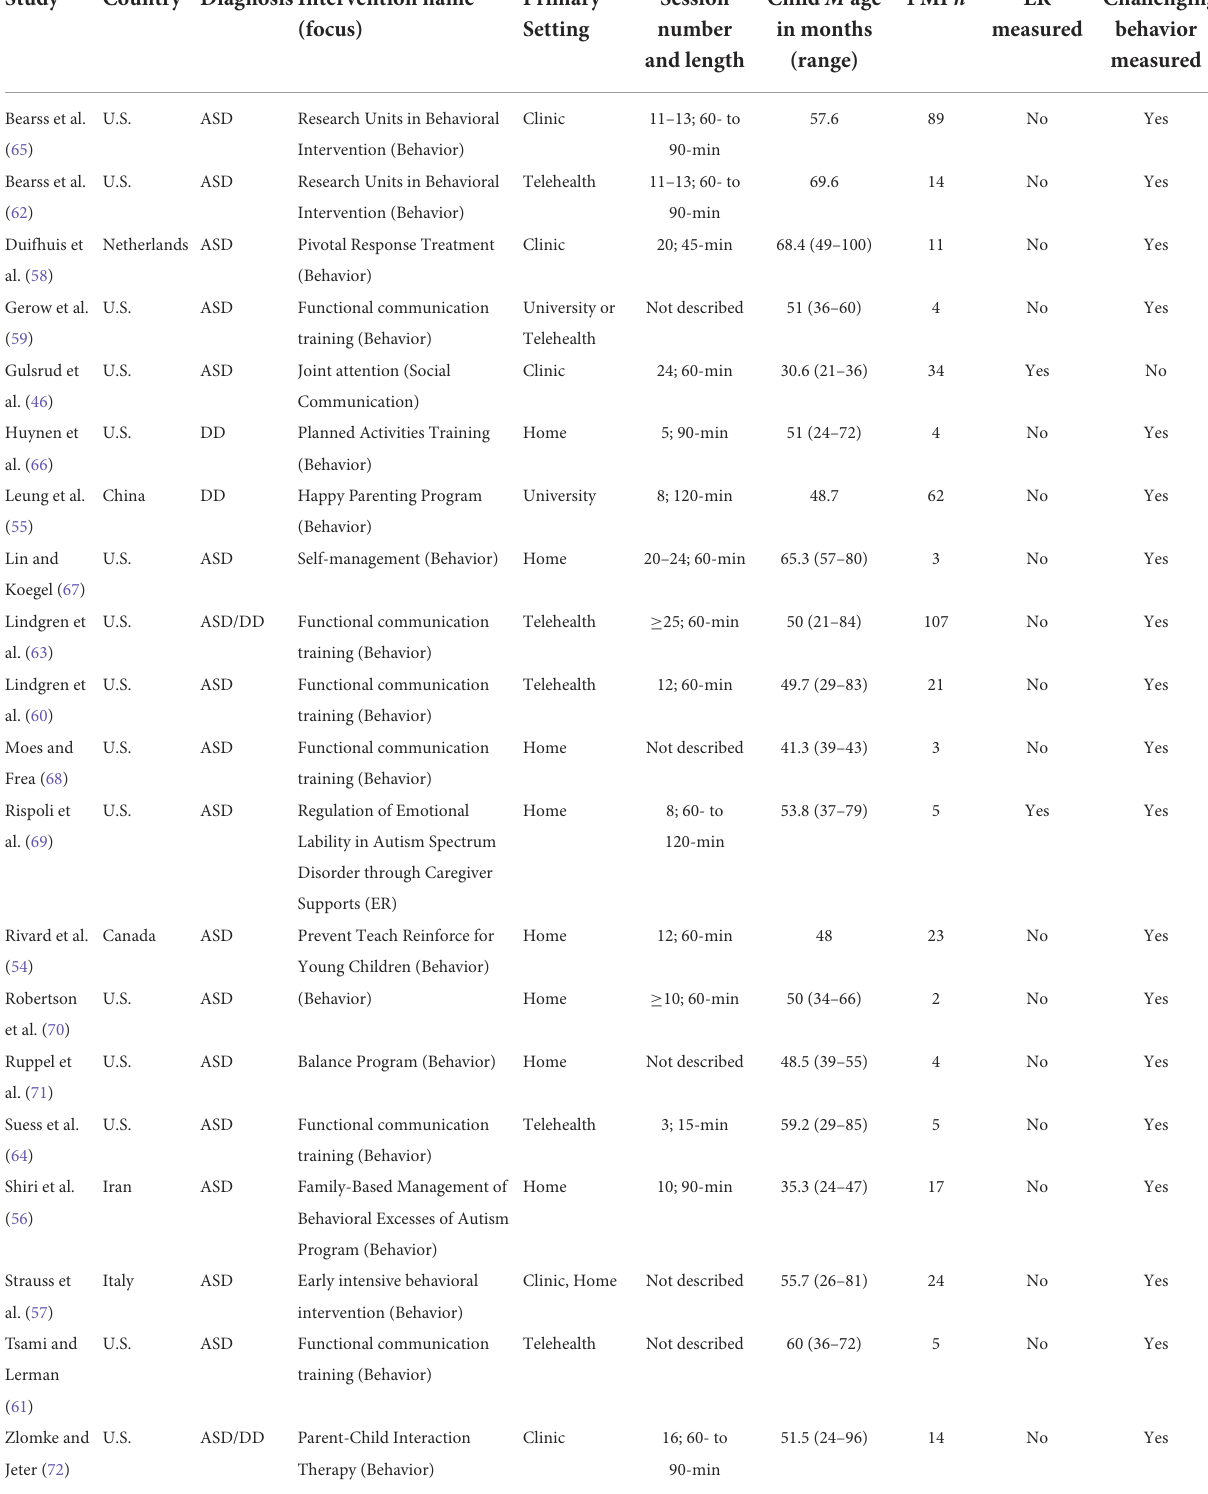
TABLE 1 Summary of studies addressing emotion regulation (ER) and/or challenging behavior (CB) via parent-mediated intervention (PMI).